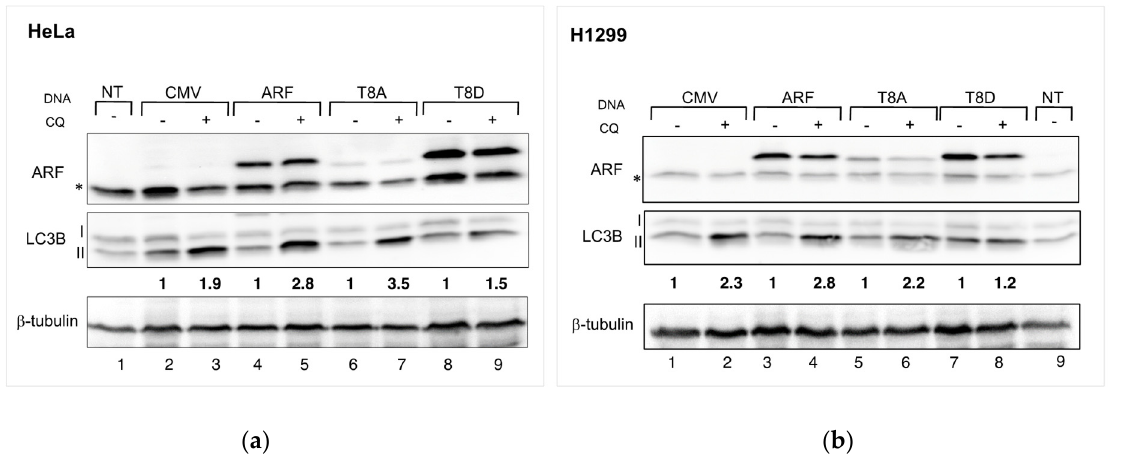
Figure 2. ( a ) HeLa cells, transfected with the indicated plasmids, were incubated with 50 μ M CQ twenty-four hours after transfection, as described in Materials and Methods. Cell extracts were sub- jected to SDS-page and incubated with anti-ARF to check exogenous expression, tubulin as a loading control and anti-LC3 to measure the autophagic flux. ( b ) H1299 cells treated as in ( a ). Densitometric analysis of LC3B-II levels were normalized vs. tubulin and in CQ treated samples are expressed as fold increase relative to LC3B-II level in untreated cells, in which it has been arbitrarily set to 1. The so obtained autophagic flux is reported below the Western for each transfection. Densitometric analysis was performed with Fiji (See Materials and Methods for details). Representative images of three independent experiments are shown. Asterisks indicate endogenous expressed ARF.